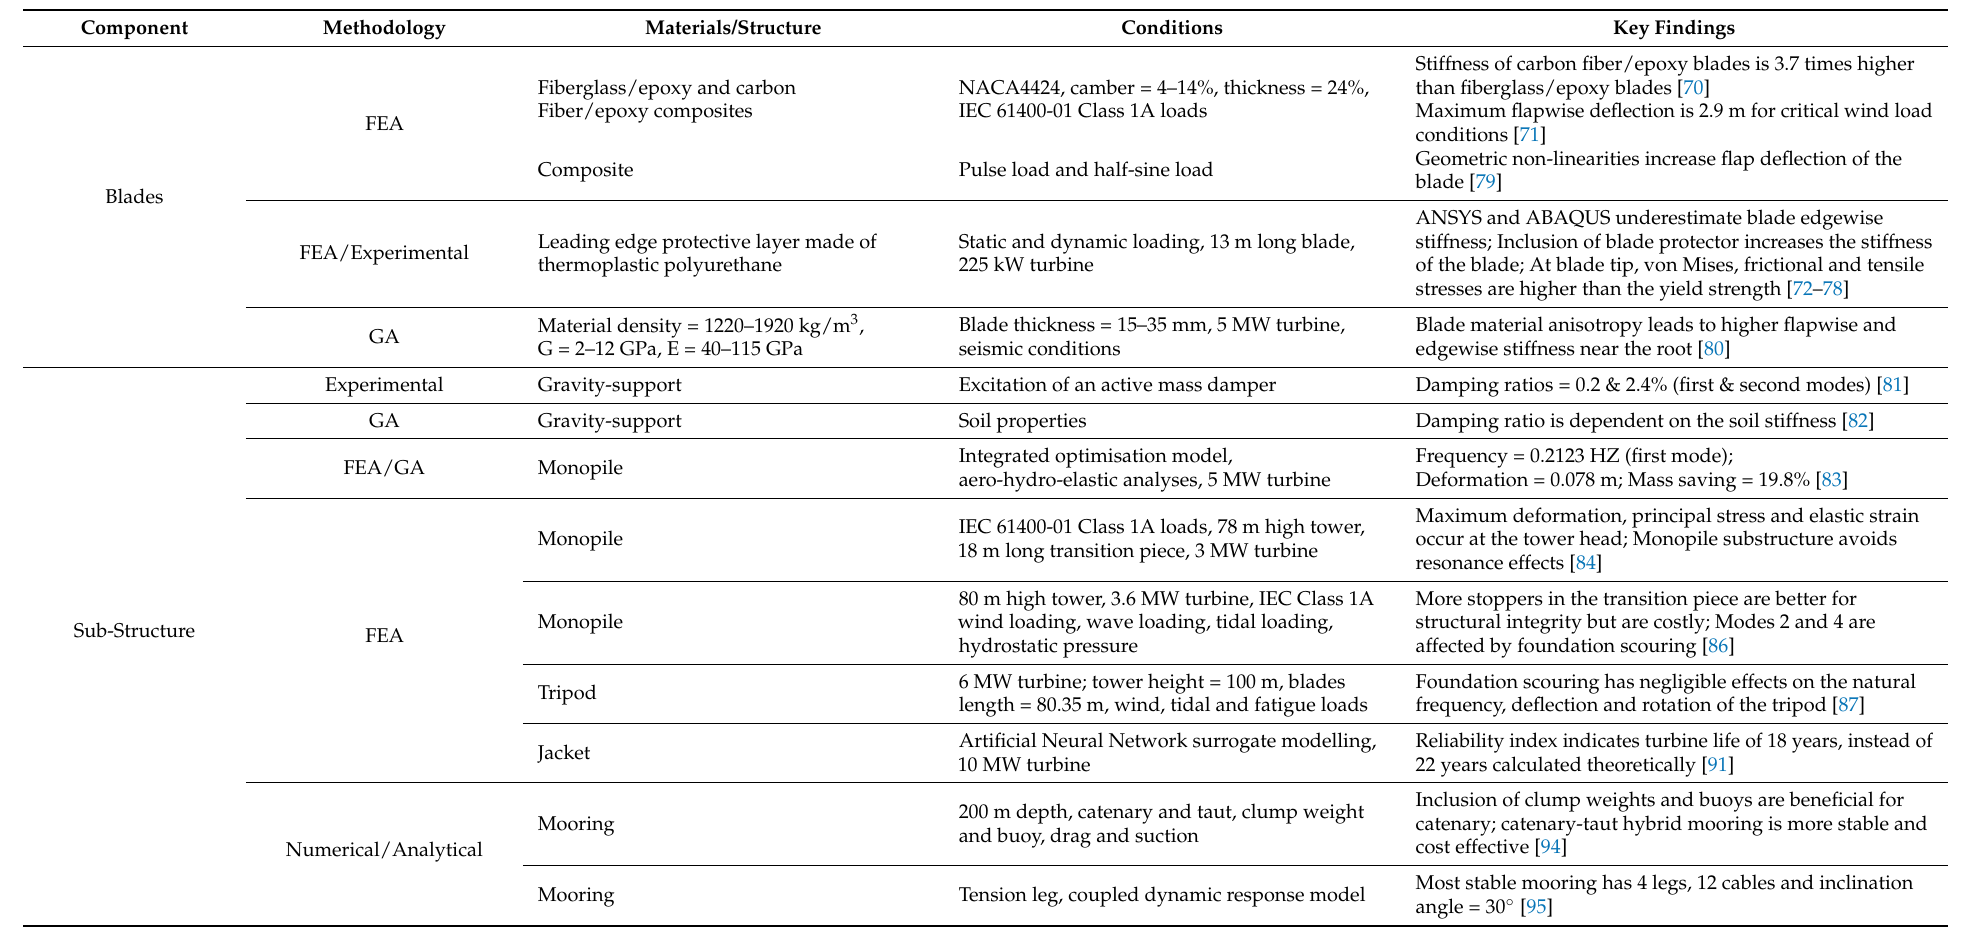
Table 4. Summary of literature review on the structural integrity of offshore wind